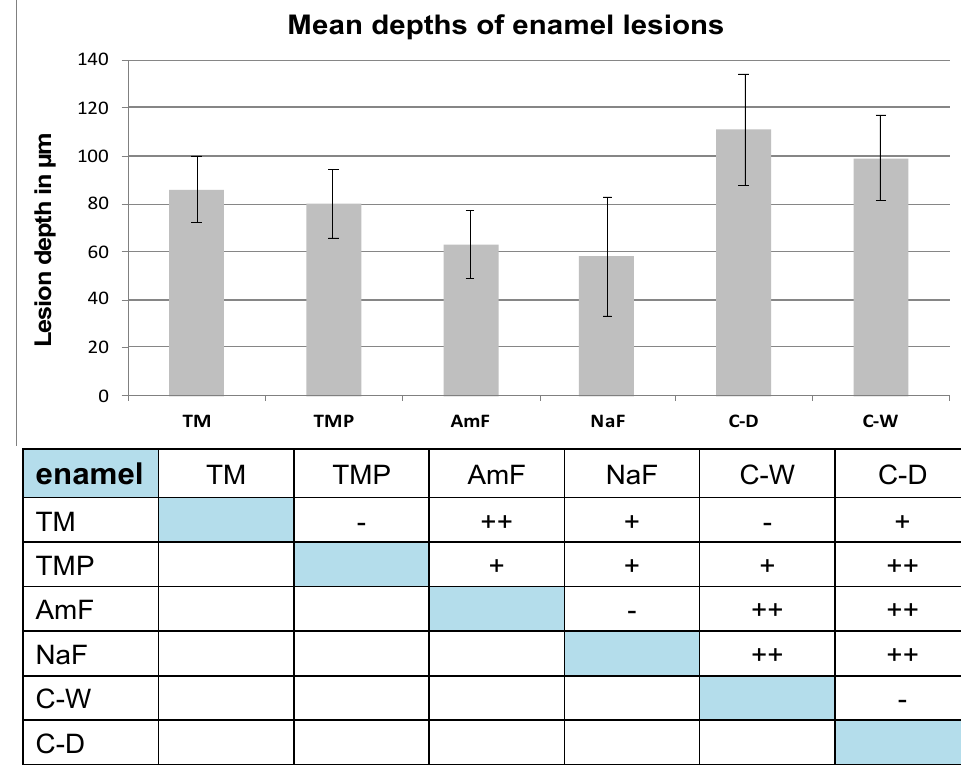
Figure 3. Mean lesion depths and standard deviations of enamel lesions. Below the statistical evaluation of lesion depths regarding significance between the different test groups for enamel groups: − not significant ( p ≥ 0.05); + significant ( p ≤ 0.01); ++ highly significant ( p ≤ 0.001). Data were analyzed by ANOVA i.a.